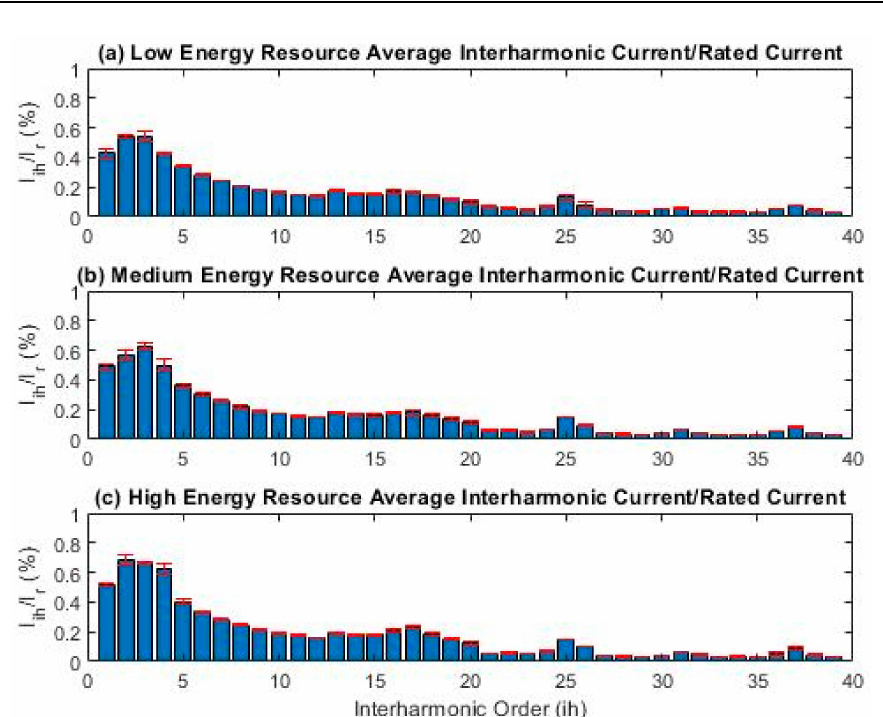
Figure 9. Laboratory trials average ratio of interharmonic current amplitude to rated current for ( a ) low energy, ( b ) medium energy, and ( c ) high energy resource classifications including errorbars that represent the standard deviation of the data